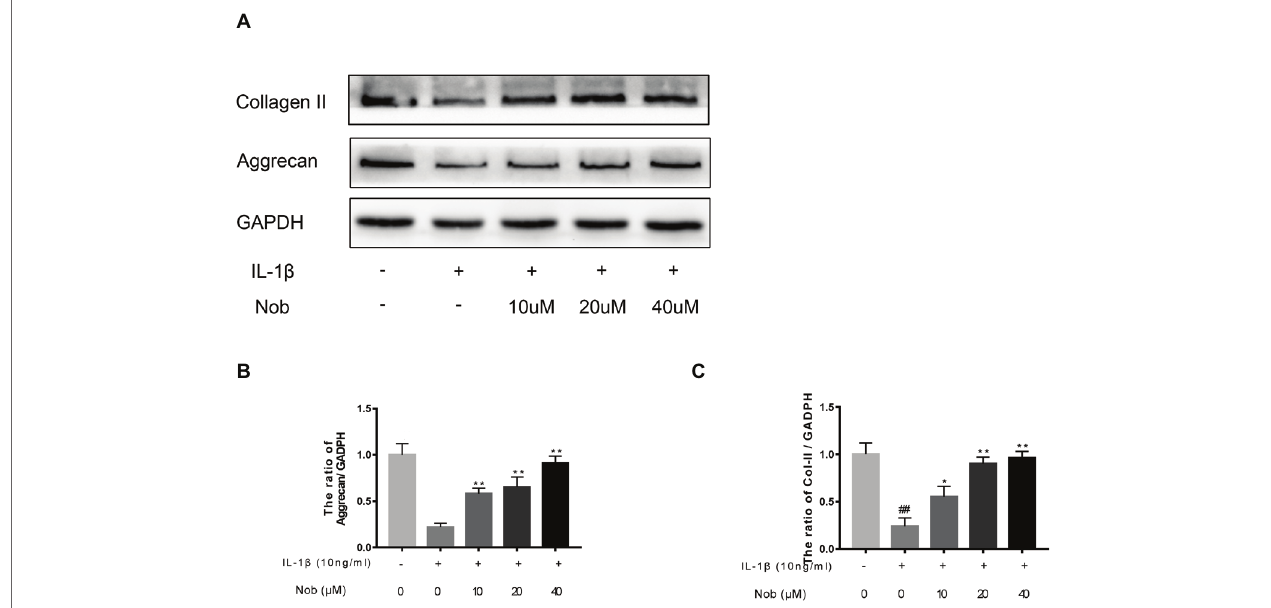
FIGURE 5 | Effects of nobiletin on collagen II and aggrecan expression in mouse chondrocytes. Cells were pretreated with various concentrations of nobiletin (0, 10, 20, and 40 μM, 24 h) before stimulation with IL-1 β (10 ng/ml, 24 h). The expression of collagen II and aggrecan was assessed by Western blot analysis (A–C) . Values represent mean ± SD of three independent experiments. Significant differences are indicated as * p < 0.05 and ** p < 0.01, compared with control group. * p < 0.05 and ** p < 0.01, compared with IL-1 β group. ## p < 0.01, compared to the control